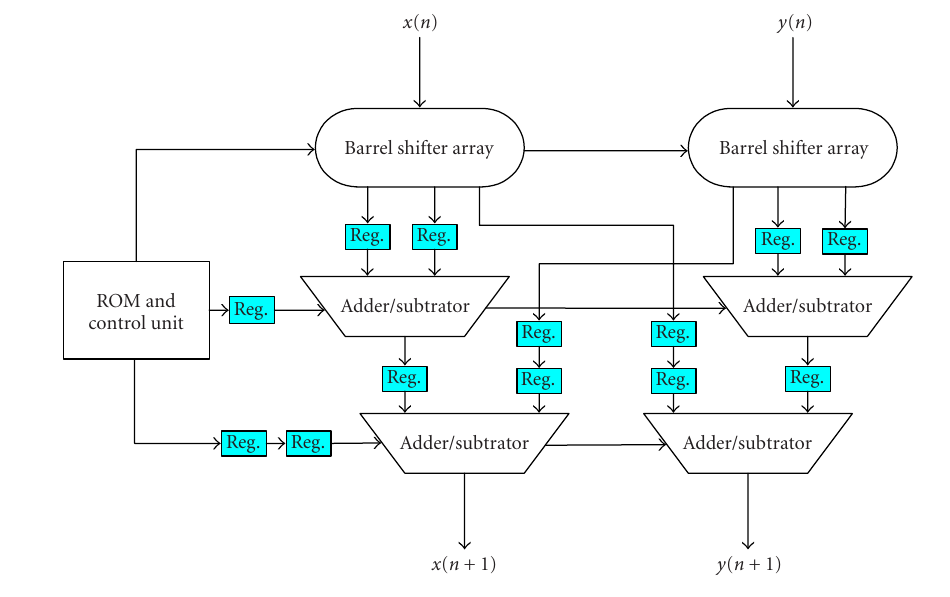
Figure 6: MSR-CORDIC-( N spt = 3, I = 2, and J = 1) based PE structure with two-level pipeline.